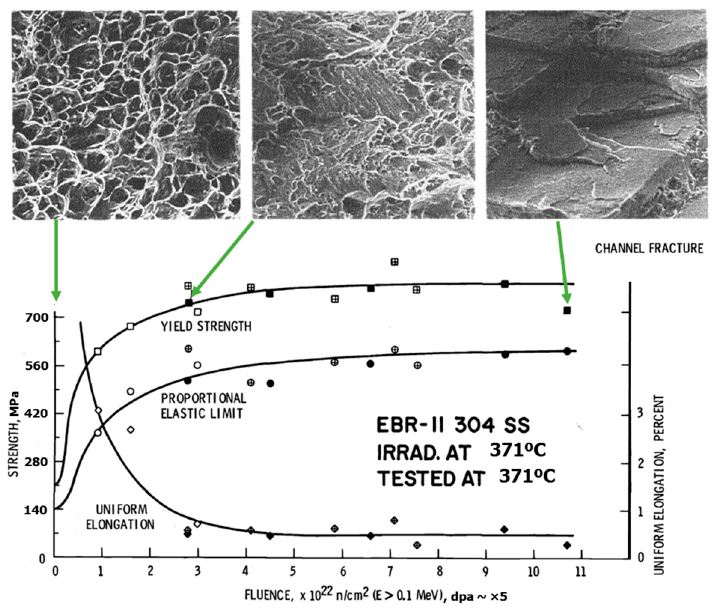
Figure 10. Effect of irradiation fluence on the yield strength and the uniform elongation of annealed 304 austenitic stainless steel (ASS) showing changing fracture appearance owing to increased plastic flow localization [30]. Note the channel fracture at ~54 dpa. Adapted and modified according [31] with courtesy of F. A. Garner.